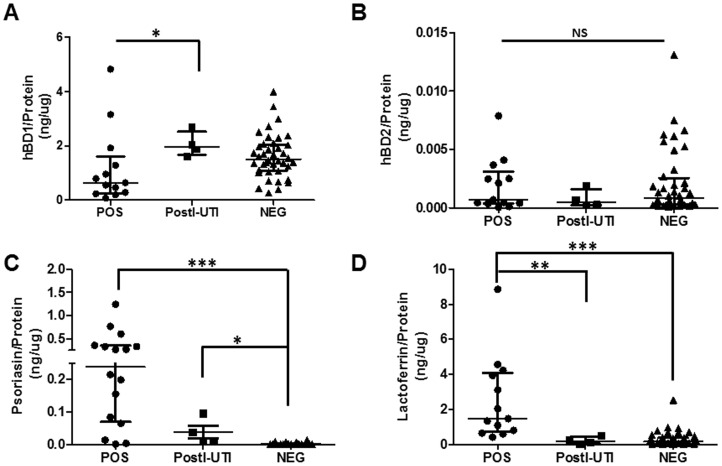
Urinary AMP protein levels in each UTI cohort.Urinary AMP levels were determined by ELISA and normalized to total urinary protein. A. human β-defensin-1 (HBD1) normalized to total protein. B. human β-defensin-2 (HBD2) normalized to total protein. C. Psoriasin normalized to total protein. D. Lactoferrin normalized to total protein. *p<0.05; **p<0.01; ***p<0.001 by One-way ANOVA and Dunn's post-test. Median with interquartile range is shown for each AMP.